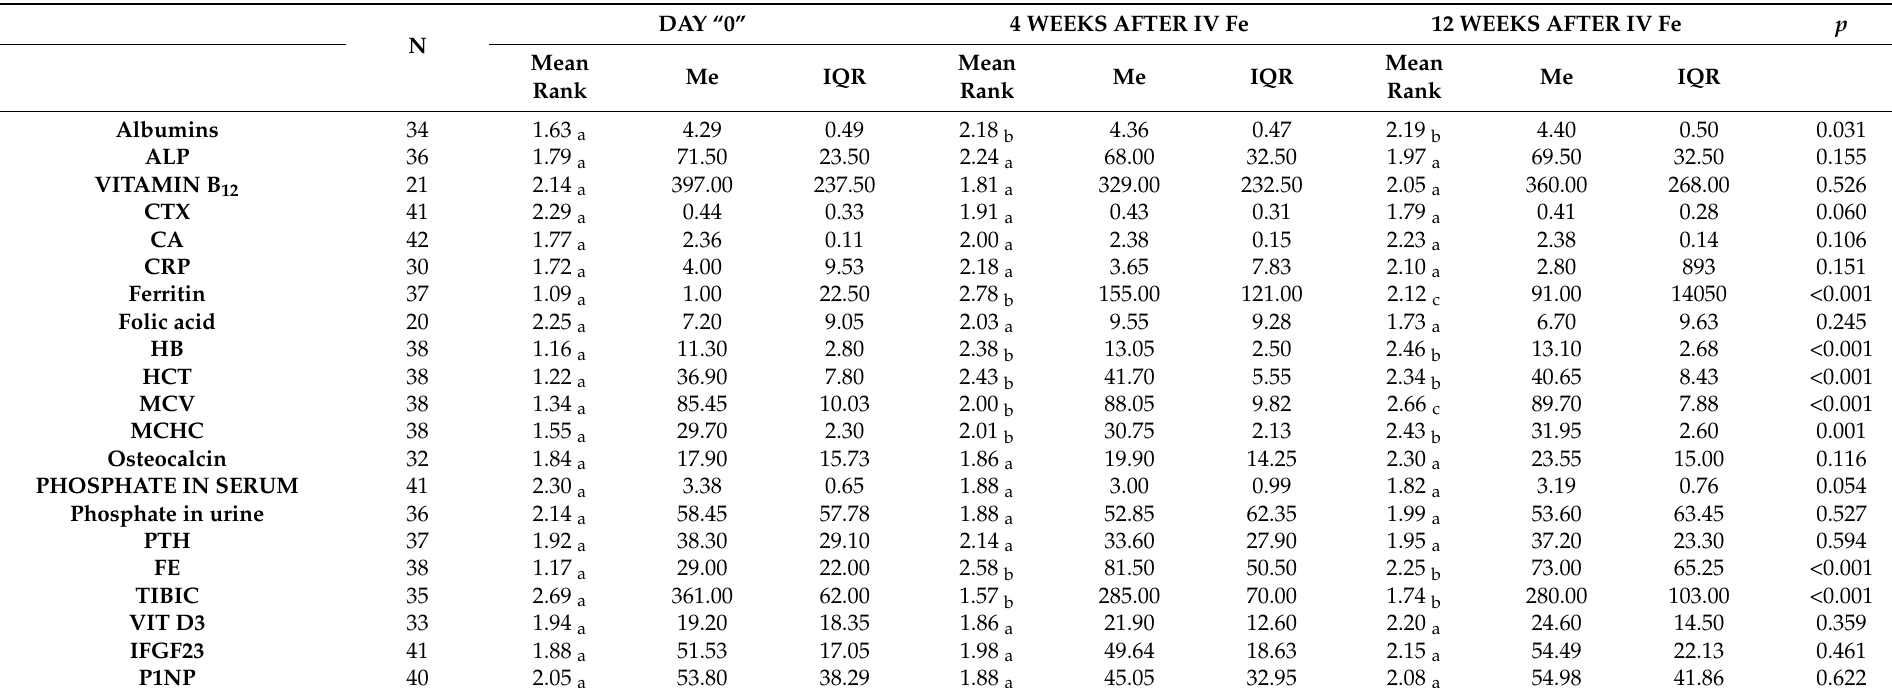
Table 2. The influence of iron formulations on the tested parameters in 3 measurements, including post hoc